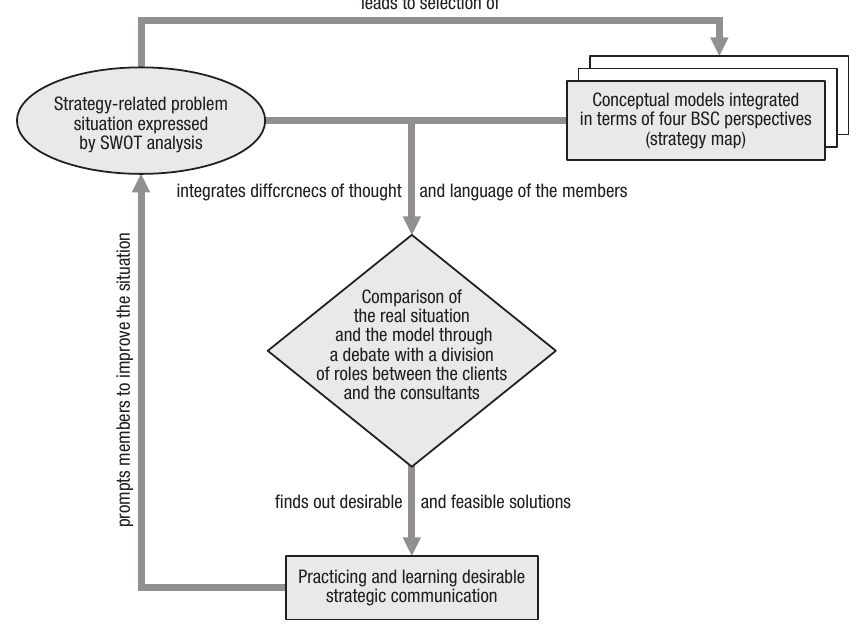
Fig. 8. The basic shape of SSM-SC (Ishino and Kijima